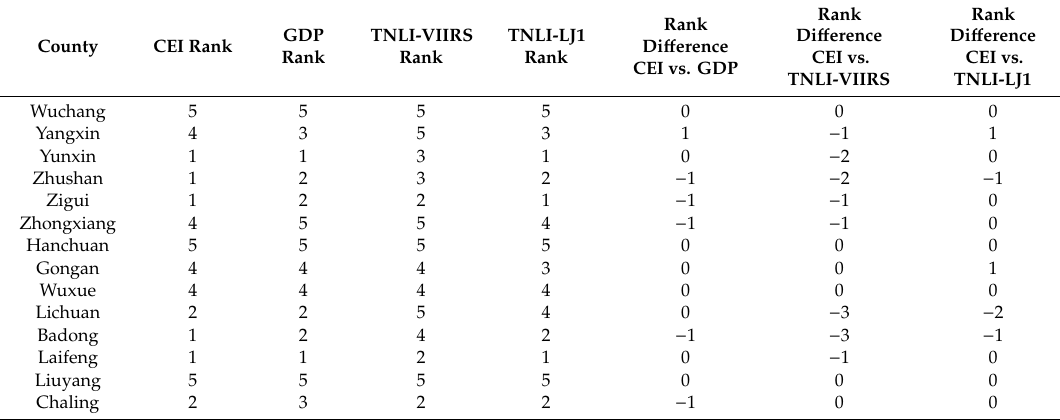
Table 5. Comparison of class ranks between the CEI, GDP and